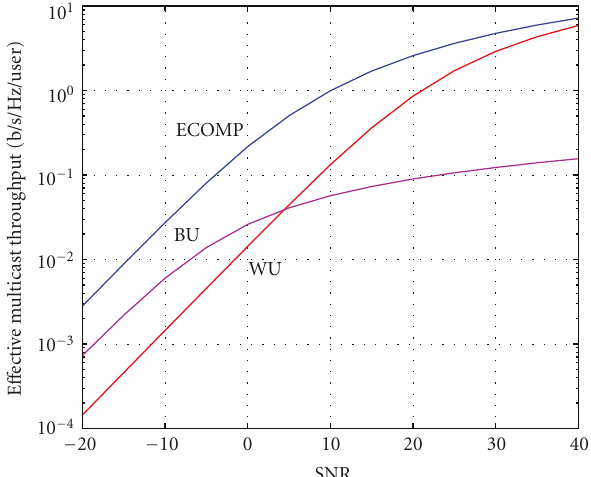
Figure 12: Throughputs of di ff erent schemes versus average SNRs (5 taps, 100